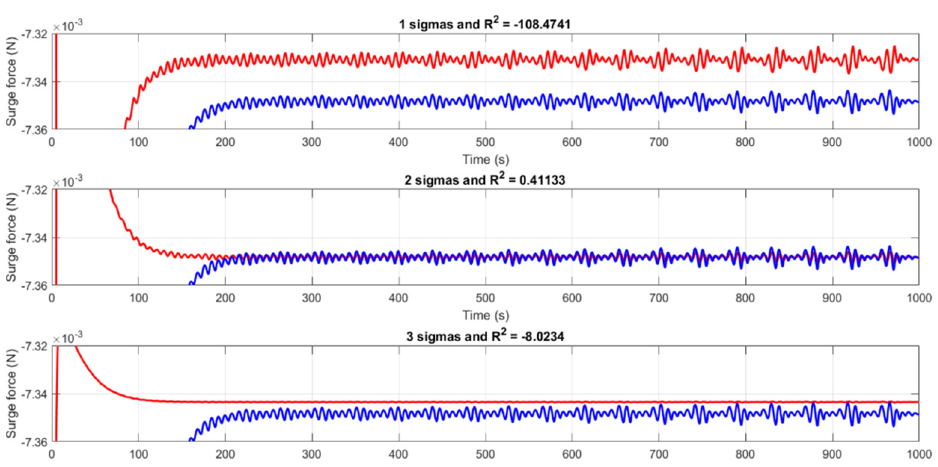
Figure 3. Measured surge force (blue curves) vs. estimated surge forces (red curves) for 25° turning manoeuvre.